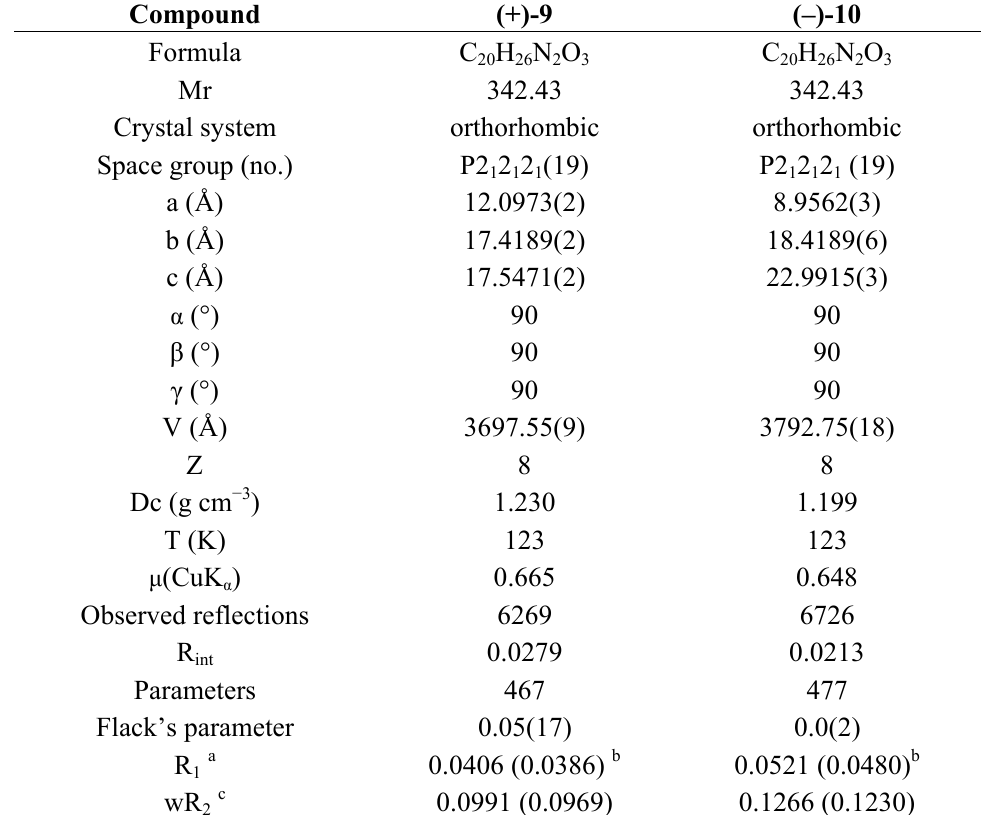
Table 2. Crystallographic data for compounds (+)- 9 and (–)- 10 .